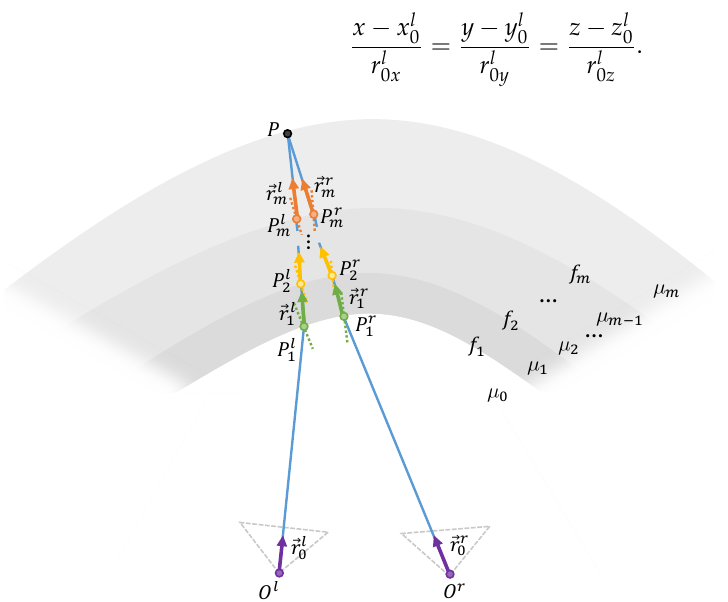
Figure 2. Diagram of the GU-RSRT model. Table 1. Notation for the GU-RSRT